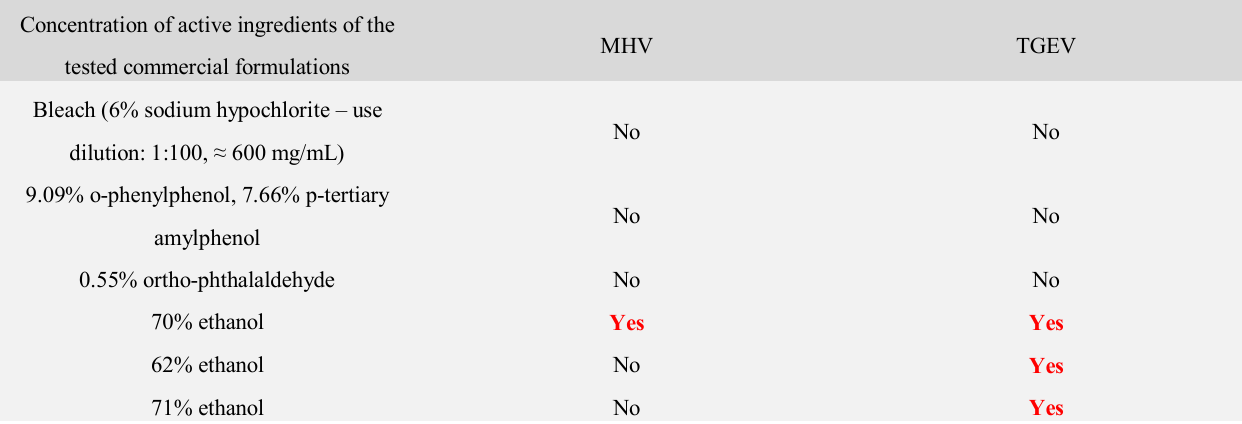
Table 4. Virucidal activity on MHV and TGEV, used as SARS-CoV surrogates, of different hand-rub formulations and surface disinfectants using carrier test